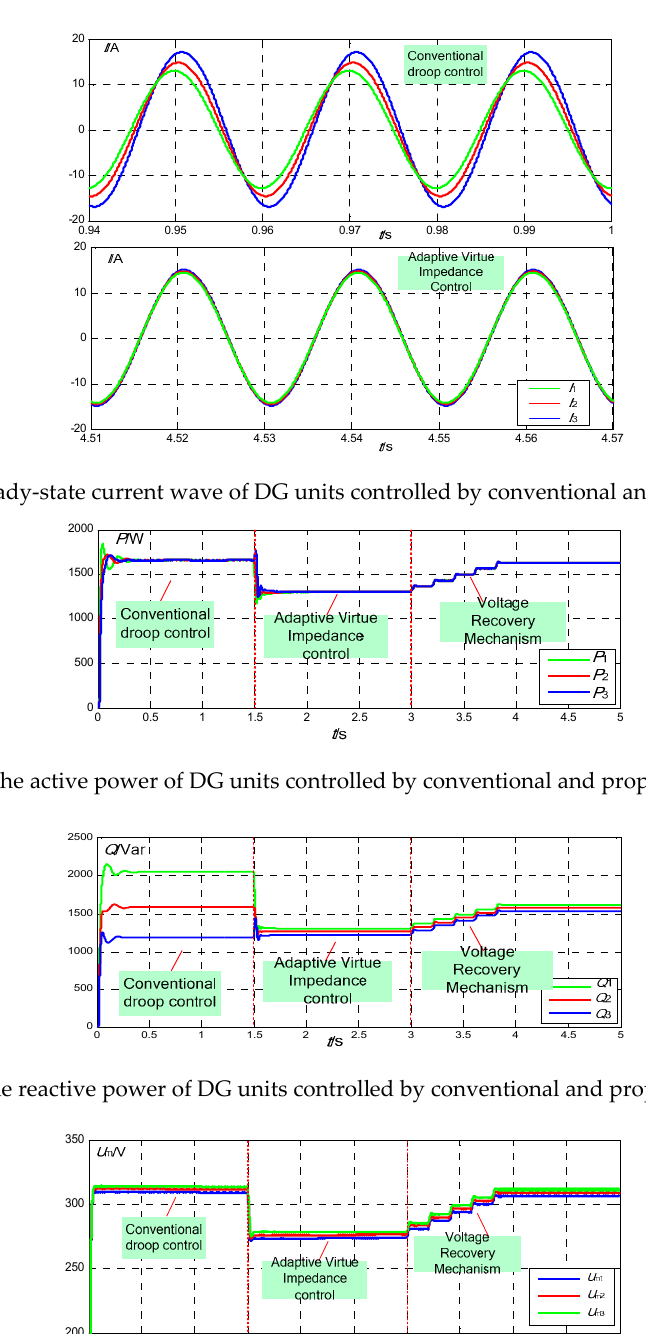
vir E vir E Figure 5. Simulink scheme of the single DG unit. Table 1. The circuit and control parameters of the DG unit. Coefficient